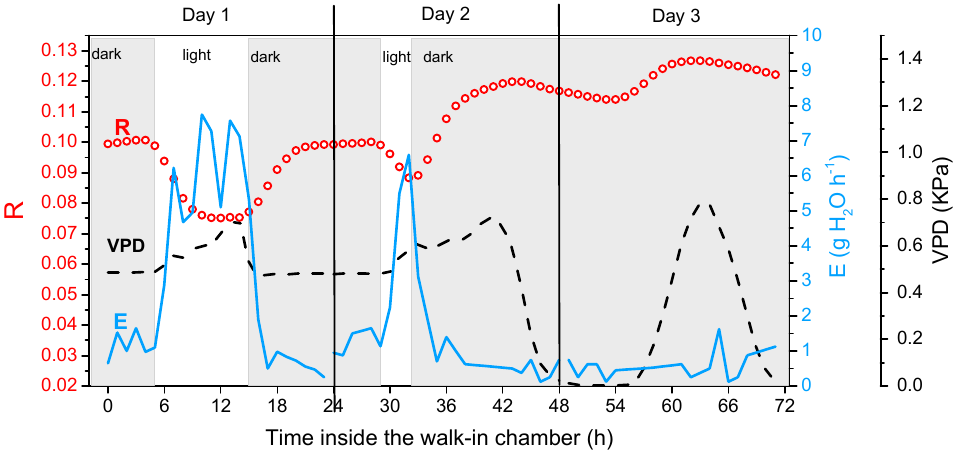
Figure 10. Diurnal pattern of bioristor signal R (circle), transpiration (E, continuous line) and VPD (dashed line) recorded over 3 consecutive days inside a walk-in chamber with variable light/dark and VPD conditions. The grey filled area indicates the dark period. Here below a detailed description of variations occurring during the 3 days analyzed.